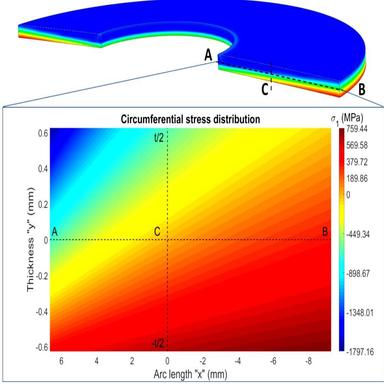
Circumferential stress distribution across the wall thickness of the disk spring ψ = 1.766° (dimensions given in b); points A, B and C lie on the middle surface.